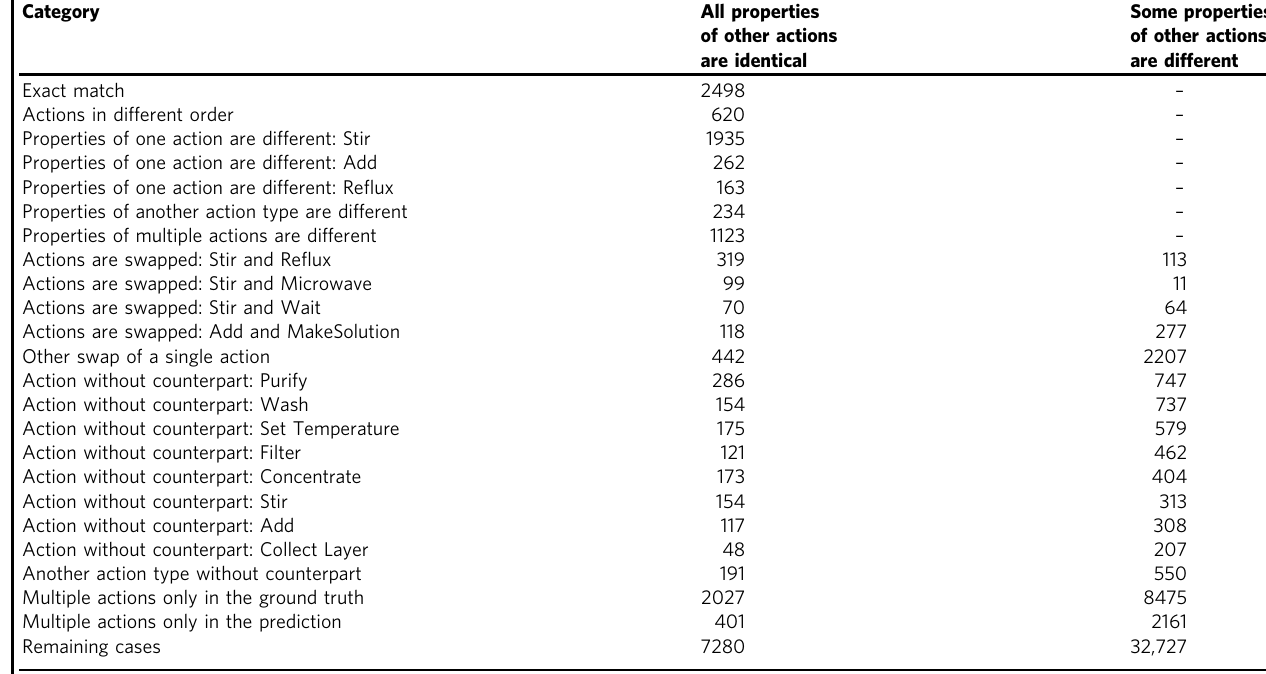
Table 5 Categorization of differences of predictions and ground